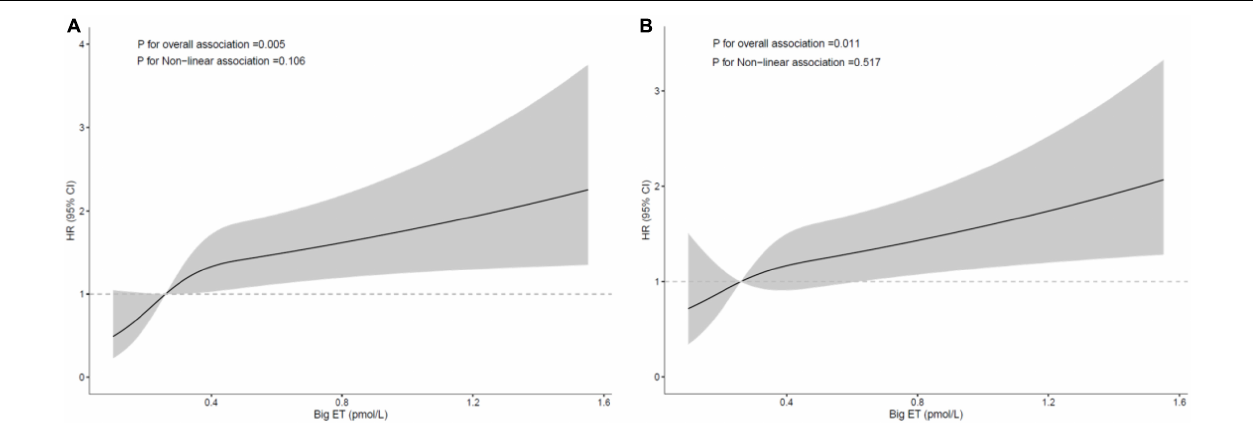
FIGURE 4 | Restricted cubic spline curve for the risk in diabetic patients according to big ET-1; (A) major adverse cardiovascular events [MACE; adjusted for age, sex, left ventricular ejection fraction (LVEF), in-stent restenosis (ISR) duration, hypertension, drug-eluting stent (DES) intervention, total cholesterol (TC), and diameter stenosis rate]; (B) secondary end points [adjusted for age, sex, high-density lipoprotein cholesterol (HDL-c), TC, reference vessel diameter, target lesion length, and diameter stenosis rate]. TABLE 6 | C-statistics of traditional risk factors and big ET-1 in patients with diabetes. MACE Secondary end points C-statistic (95% CI) (cid:49) C-statistic P -value C-statistic (95%